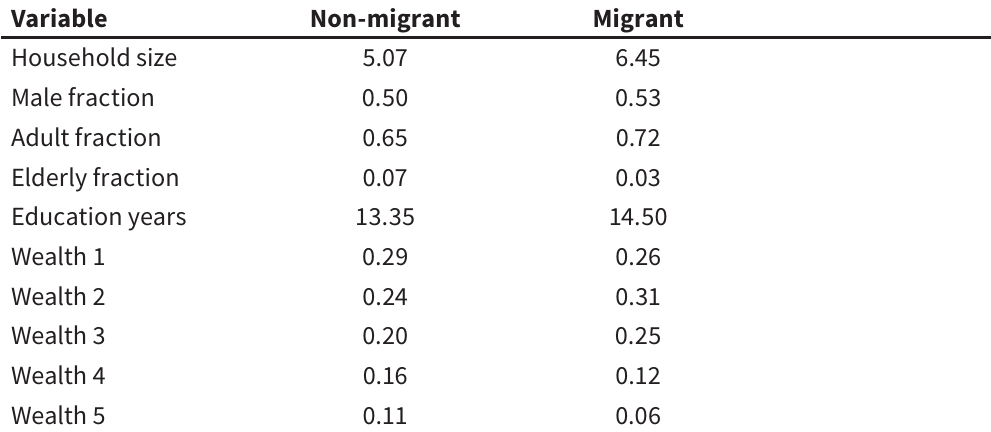
Summary of shocks (2010–2013) Variable Mean Drought